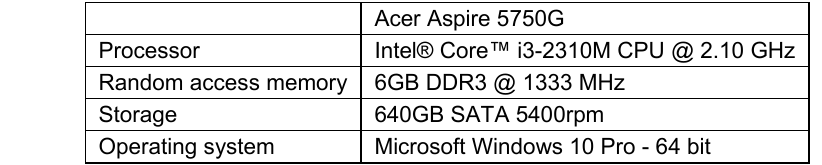
Table 3 – Computer configuration (Acer Aspire 5750G) Таблица 3 – Конфигурация компьютера (Acer Aspire 5750G) Табела 3 – Рачунарска конфигурација (Acer Aspire